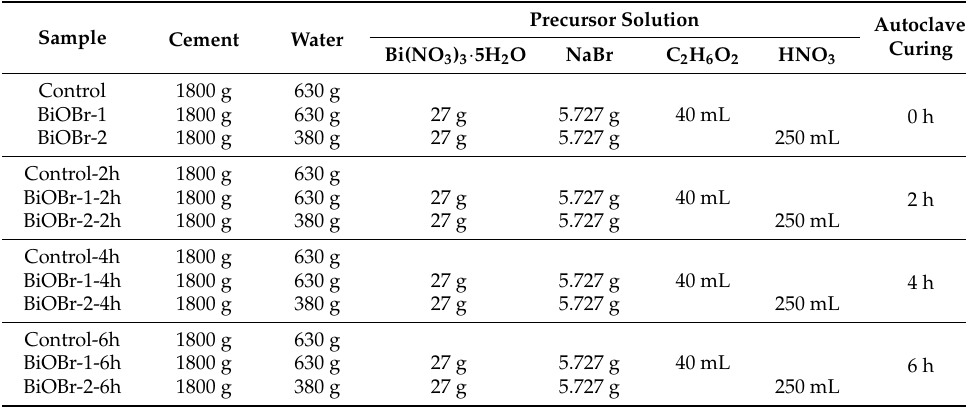
Table 1. Components and curing methods of cement paste